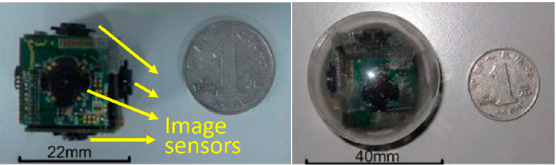
Figure 1. Prototype of the multiple cameras endoscopic capsule (MCEC), the print circuit boar (PCB) cube with six image sensors, is sealed into a transparent biocompatible plastic shell for practical